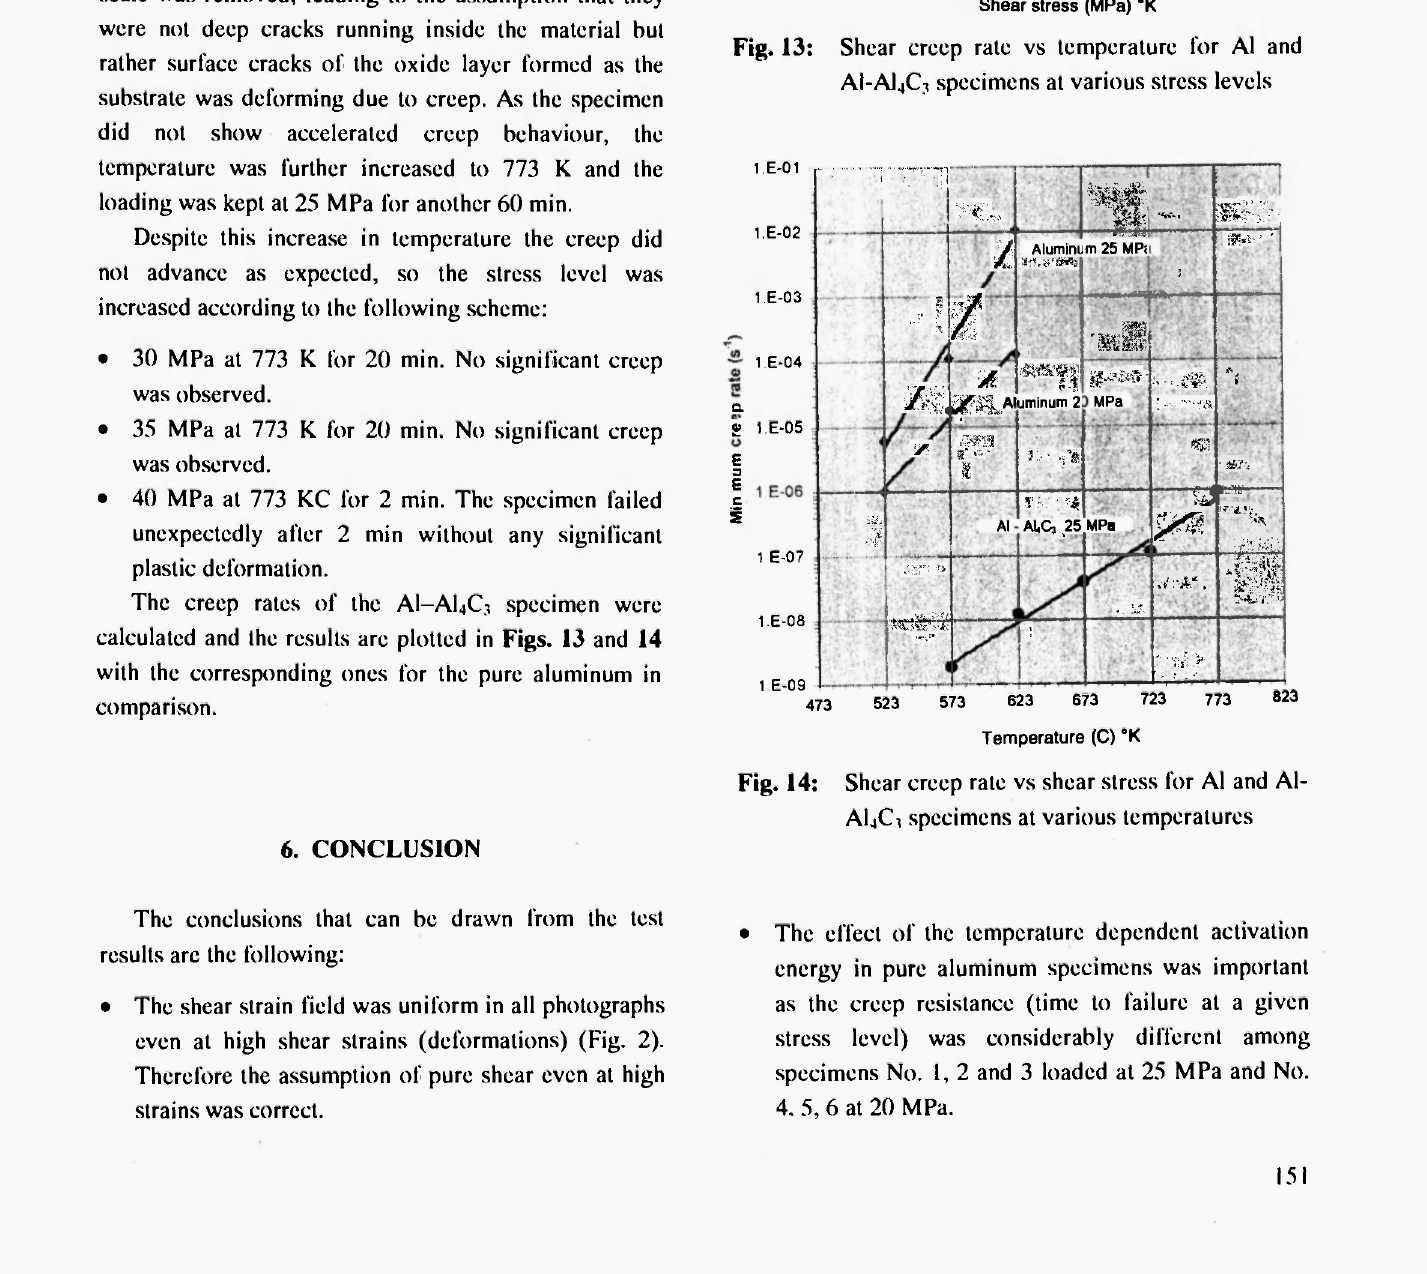
Fig. 13: Shear creep rate vs temperature for Al and A1-A] 4 Cj specimens at various stress levels